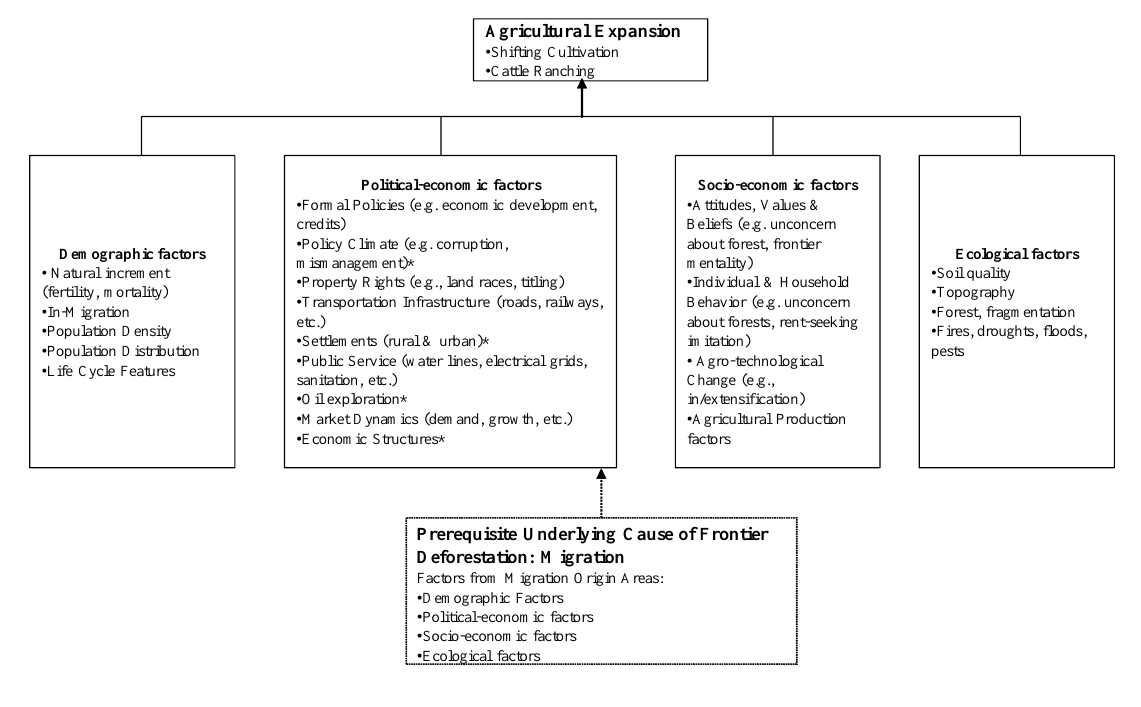
Figure 1. Factors affecting the proximate cause of deforestation in an agriculture colonization frontier: Colonist farmer land use (adapted from [7]).